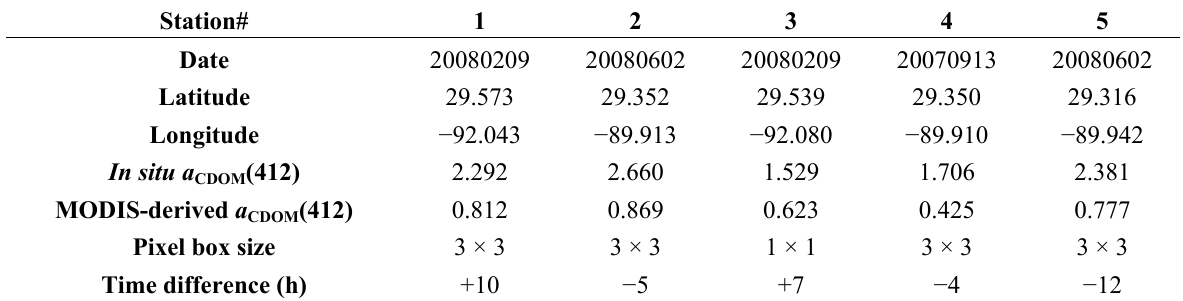
Table 8. Summary of outlier stations excluded from CDOM matchup comparison for